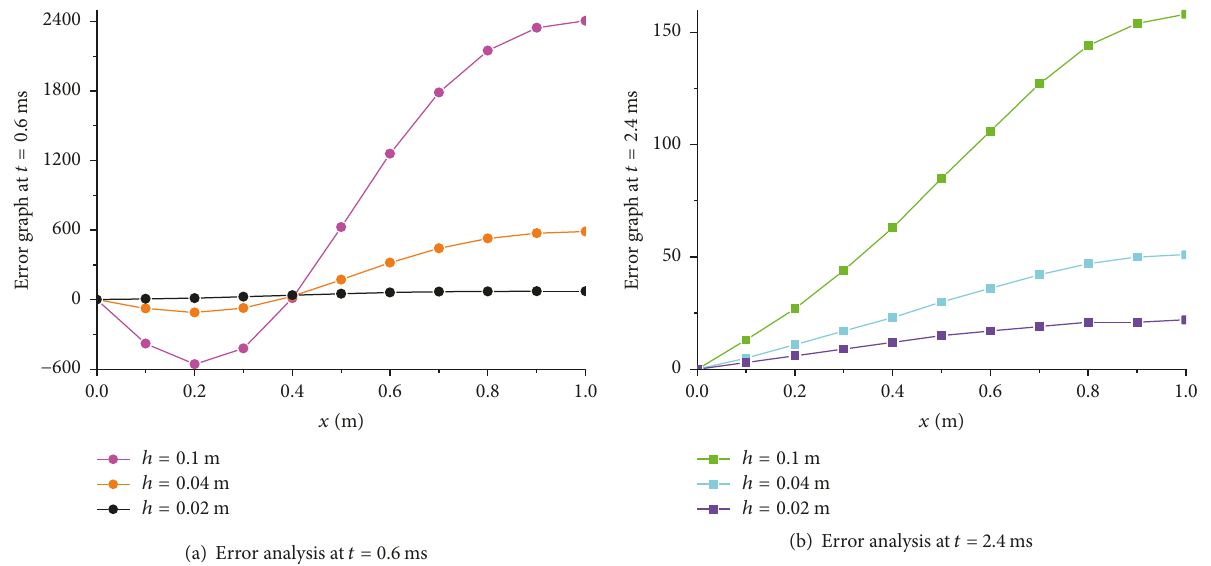
Figure 14: Error between numerical solution and analytical solution under three sets of mesh sizes at 𝑡 = 0.6 ms and 2.4 ms.